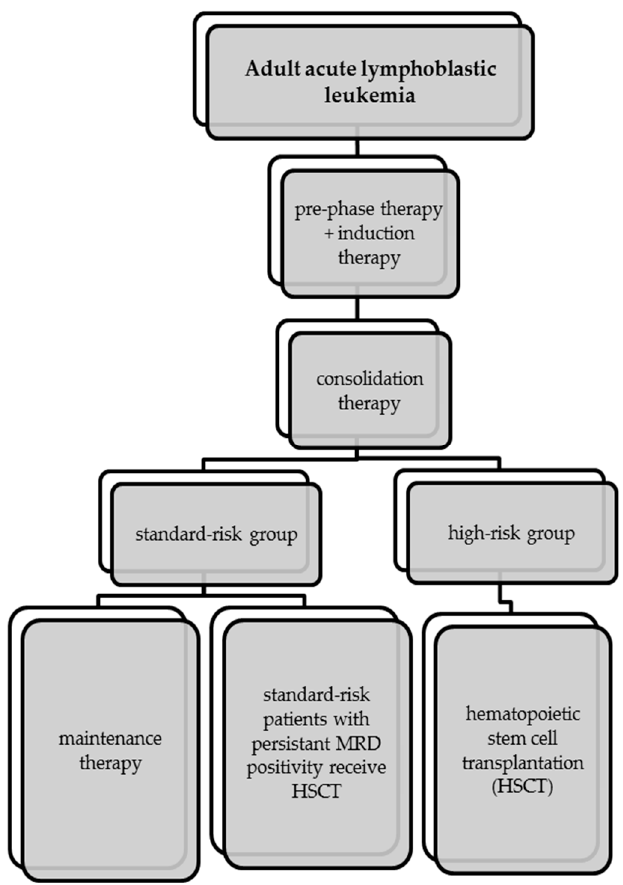
Figure 1. Standard treatment algorithm for adult Ph-ALL.